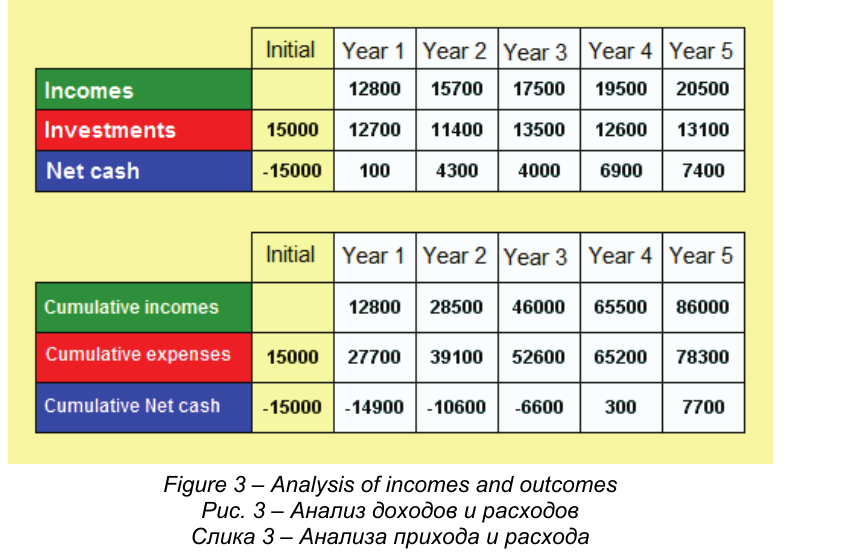
Figure 3 – Analysis of incomes and outcomes Рис . 3 – Анализ доходов и расходов